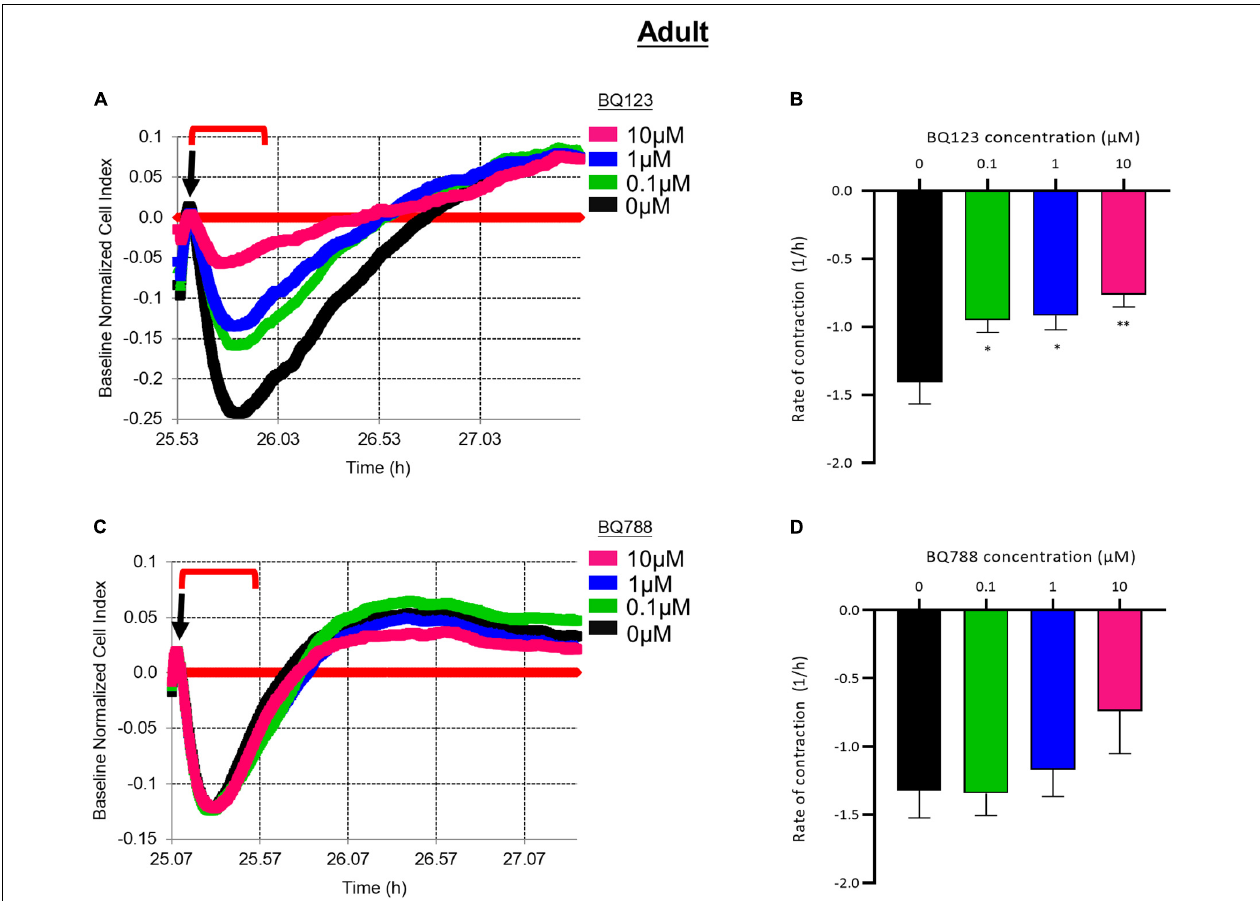
FIGURE 5 | (A) Representative electrical impedance measurements of the contractile response of adult human brain vascular pericytes (aHBVP) to EDN1 in the presence of BQ123, an EDNRA antagonist. (B) The rate of contraction was significantly reduced in cells to which 0.1 µ M ( p = 0.0241), 1 µ M ( p = 0.0154), or 10 µ M ( p = 0.0016) BQ123 had been added ( n = 7). (C) Representative electrical impedance measurements of the contractile response of aHBVP in the presence of BQ788, an EDNRB antagonist. (D) There was no significant difference in the rate of contraction between BQ788-treated and untreated cells ( n = 7). Data shows mean rate of contraction ± SEM. The timeframe referred to in each graph is indicated by the red bracket. Arrows indicate the timepoint of EDN1 addition. The bars represent the mean values and